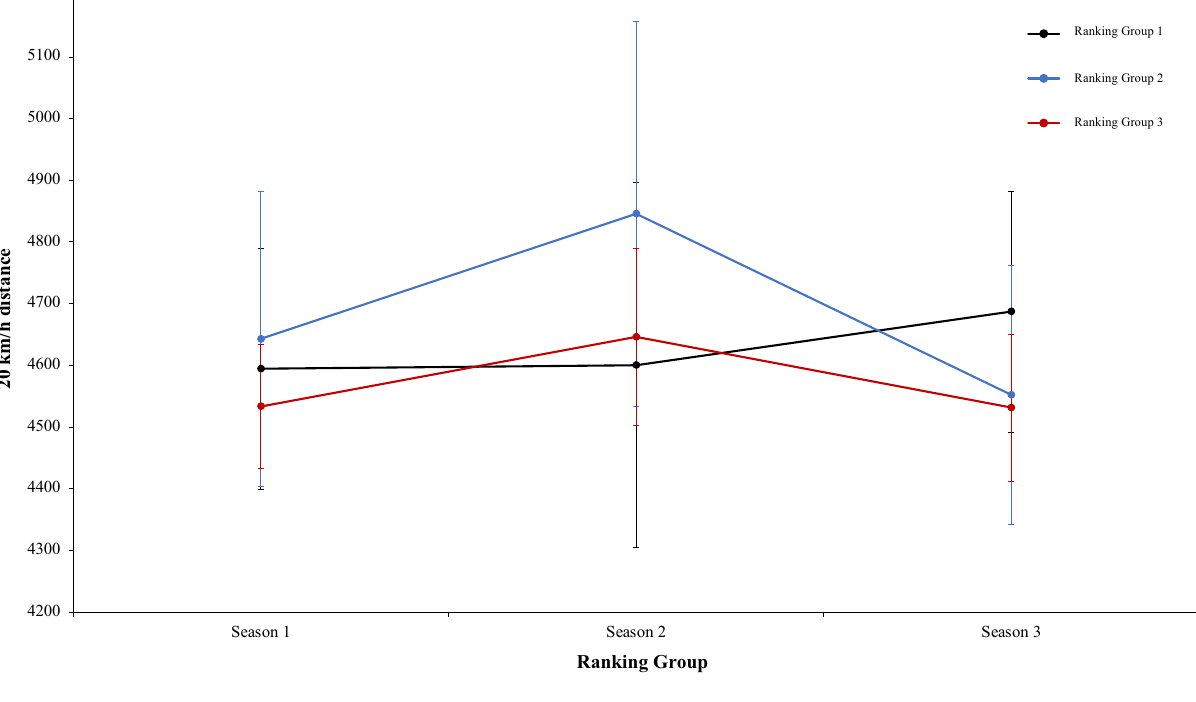
Figure 6. Physical performance. Mean THID (± SE) as a funtion of Ranking and Season Condition.